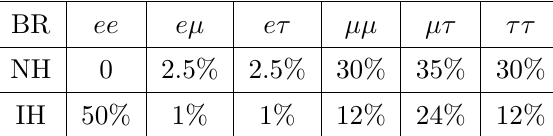
Table 1 . Benchmark decay branching ratios of doubly charged Higgs for NH and IH spectra. branching ratio, compared to e + (cid:22) + ; e + (cid:28) + as shown in (cid:12)gure 1 (c, d). In our